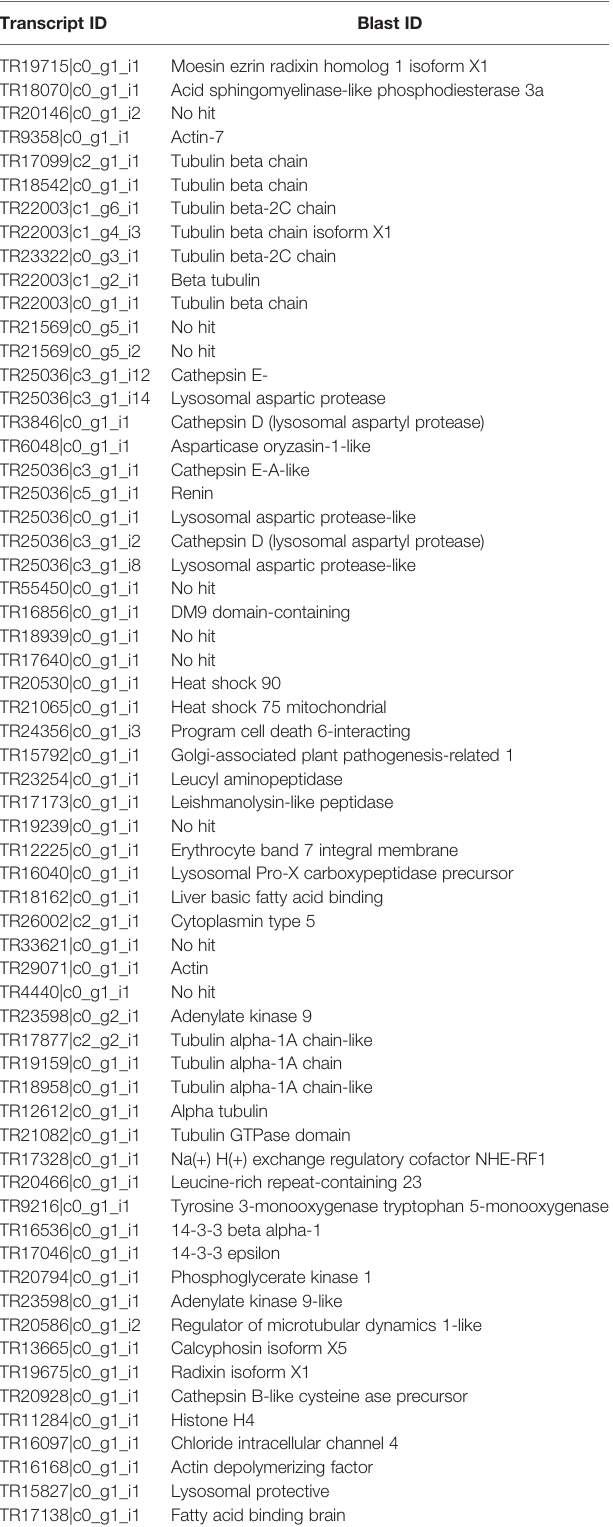
TABLE 3 | Putative proteins identi fi ed in SEC puri fi ed C. daubneyi EVs surface trypsin shave (n = 3). Transcript ID Blast